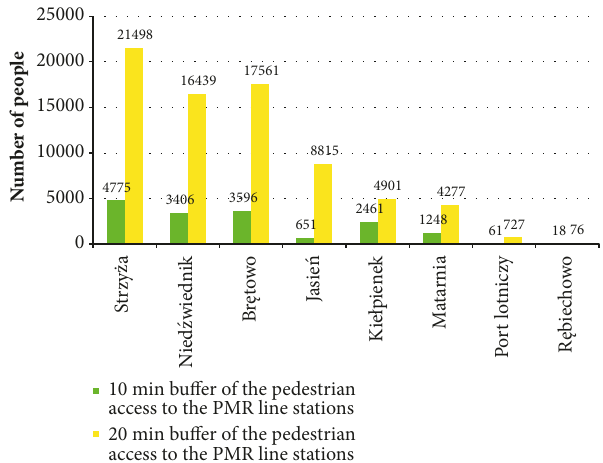
Figure 4: Population density in the zones of 10-minute and 20- minute walking accessibility to the PMR